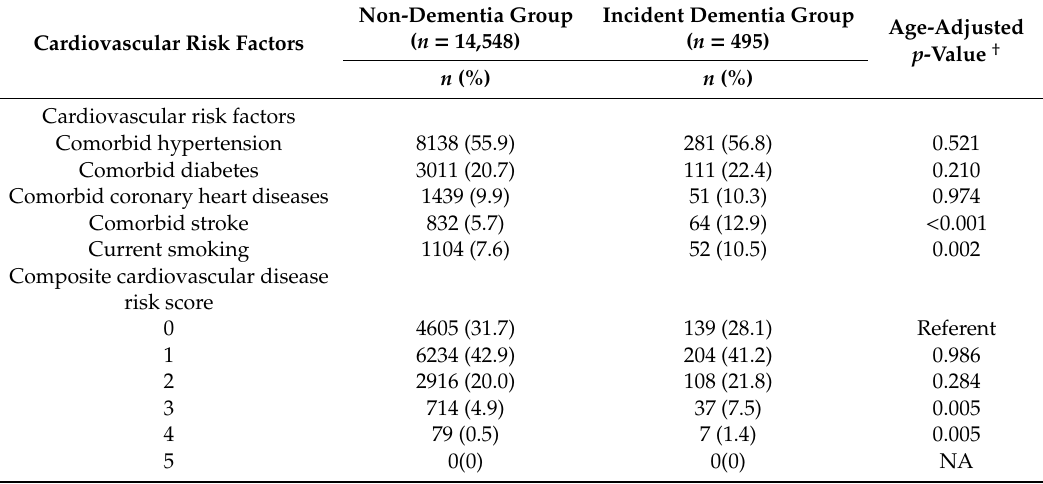
Table 2. Association between cardiovascular risk factors and dementia incidence ( n = 15,043).